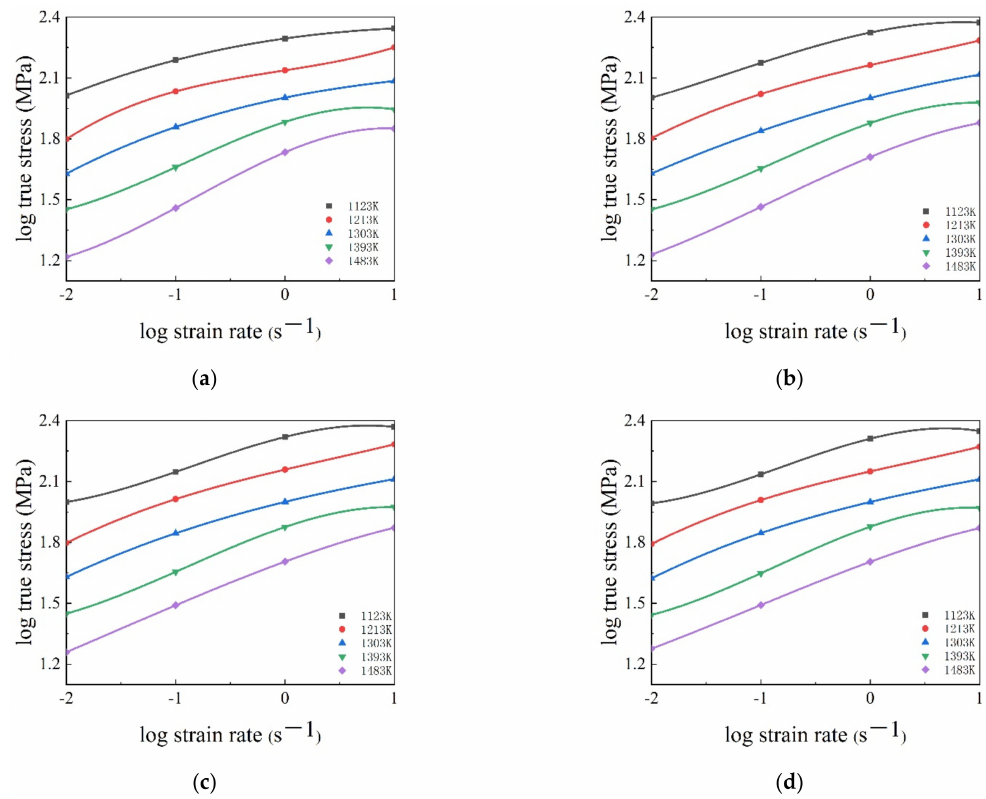
Figure 5. Relationships between stress and strain rate in log scale at different deforming temperatures and true strains of ( a ) 0.3, ( b ) 0.5, ( c ) 0.7, and ( d ) 0.9.